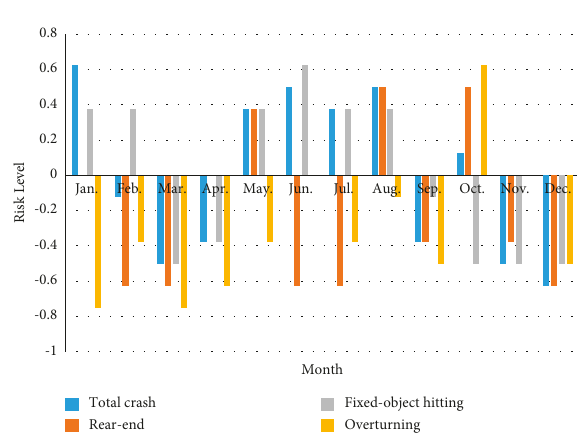
Figure 6: Monthly distribution pattern of various types of crashes based on Apriori rules.